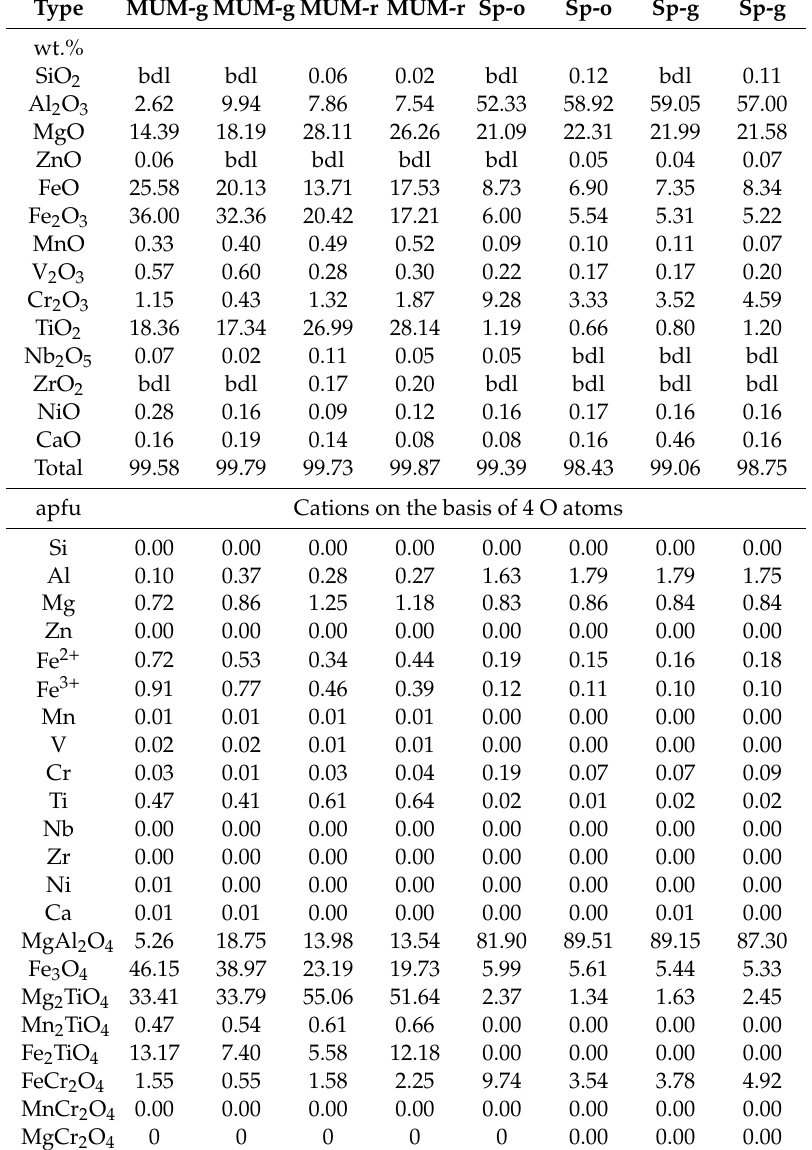
Table 1. Representative electron microprobe (EMP) analyses of spinel-group